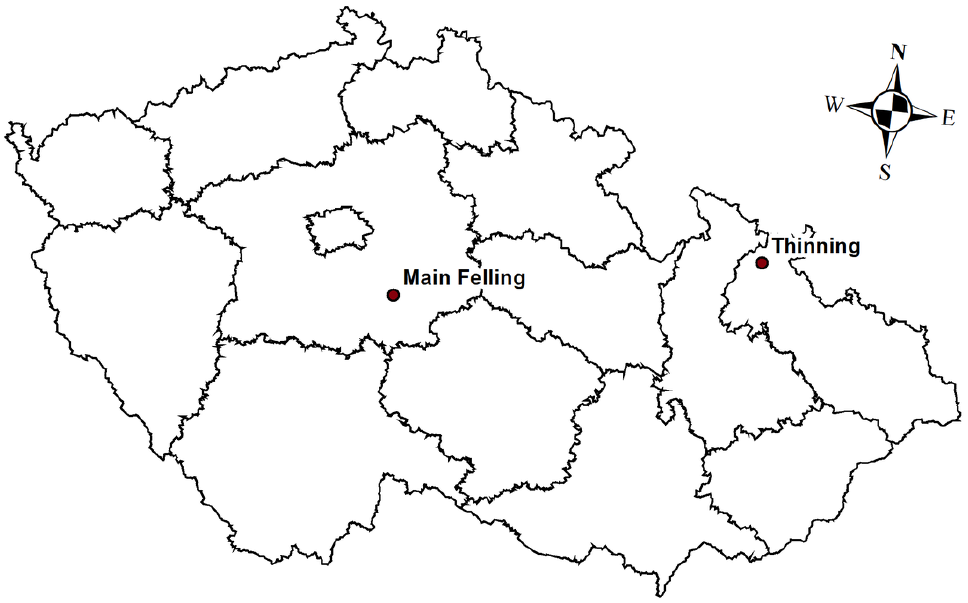
Table 1. Basic information on the research plots.